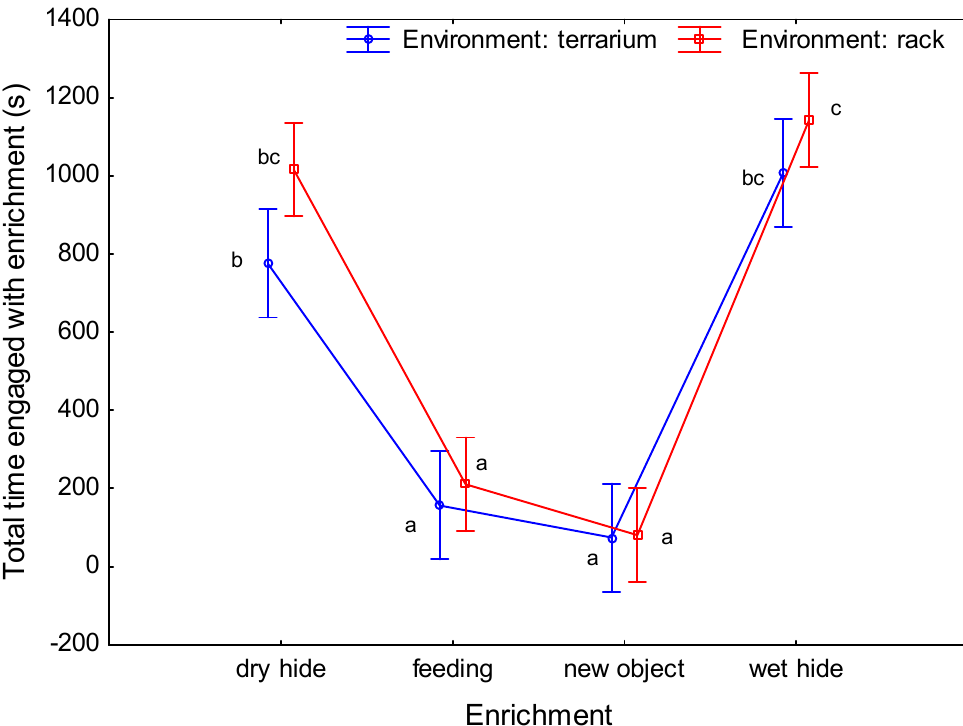
Figure 6. Mean total contact time (s) with enrichment items for tested environments (vertical bars denote 0.95 confidence intervals; groups that do not have a common letter differ signi fi cantly).